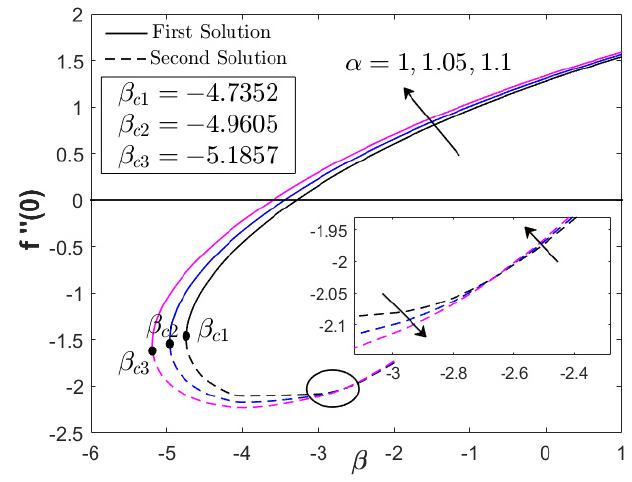
( ) 0 f ′′ for various α (acceleration parameter). Figure 5. f (cid:48)(cid:48) ( 0 ) for various α (acceleration parameter). Figure 5. ( ) 0 θ ′− for various α (acceleration parameter). Figure 6.